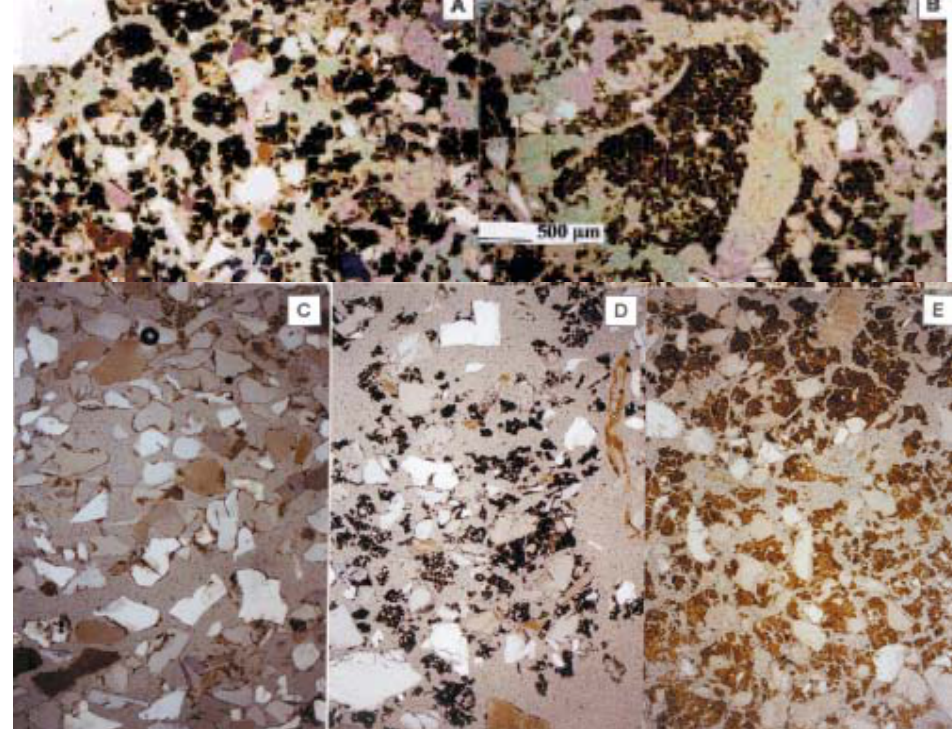
E).Figura 2. Fotomicrografias do horizonte A (fotos A e B), parte superior (foto C) e inferior (foto D) do horizonte E; transição de E para Bhs (foto